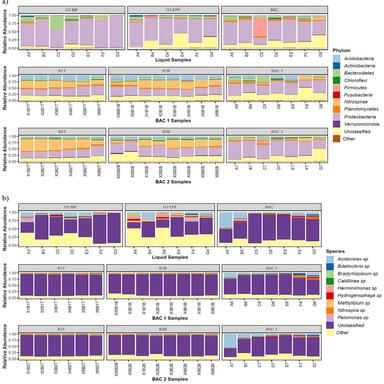
Relative abundance of top 10 a) Phylum and b) Species taxonomic levels before and after the BAC filtration step, including liquid (pre ozonation: O3 INF, post-ozonation: O3 EFF, post-BAC filters: BAC 1 EFF, BAC 2 EFF, and combined BAC EFF) and solid samples (two different depths top (T) and bottom (B) for each BAC filter).